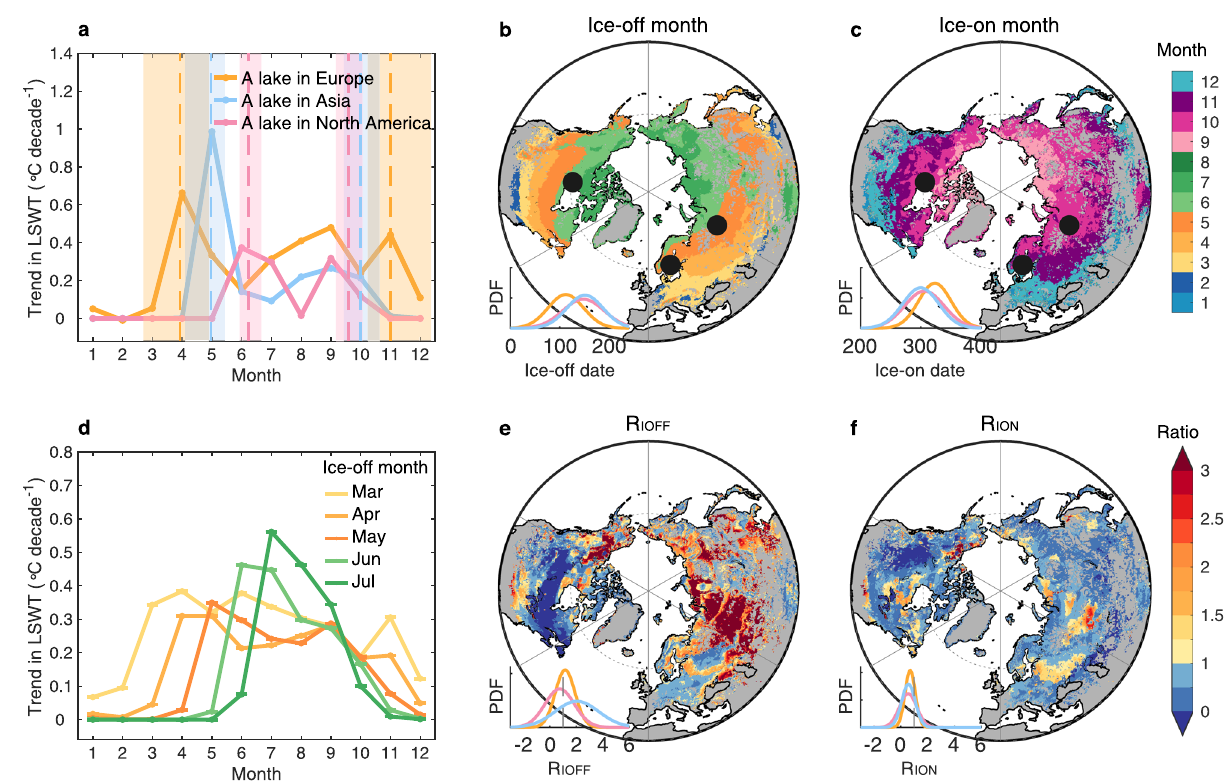
Fig. 1 | Excess lake warming in the ice-off or ice-on month. a Trends in monthly lake surface water temperature (LSWT) from 1979 to 2020 across three lakes in Europe, Asia and North America, respectively. The location of the three lakes is shownasblack dots in b , c . The dashed lines and shadedareasrepresent the mean and range of ice-off date or ice-on date from 1979 to 2020. b , c Spatial pattern of meanice-offmonth( b ),ice-onmonth( c ). d MeantrendinmonthlyLSWTfrom1979